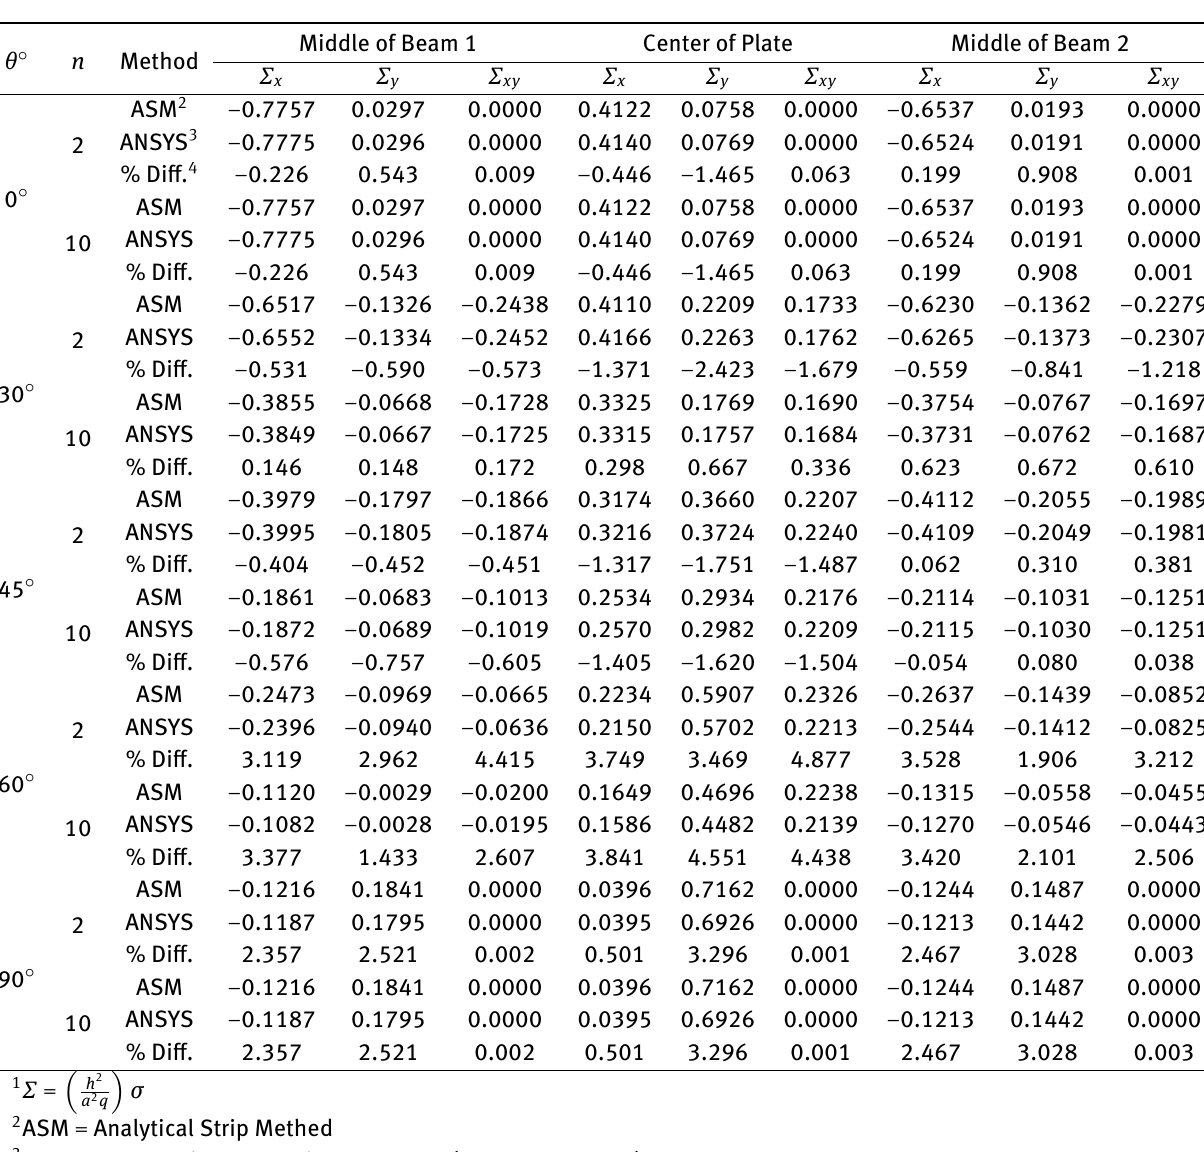
Table 8: Effect of ply angle, θ and number of layers, n , on the stress Σ 1 at the center of the plate and beams of a uniformly loaded rectangu- lar antisymmetric angle-ply plate ( a / b = 2, θ ∘ / − θ ∘ / θ ∘ / . . . / − θ ∘ ) with two internal beam supports (Fig. 4) ( b / h = 1000, E 1 = 132.38